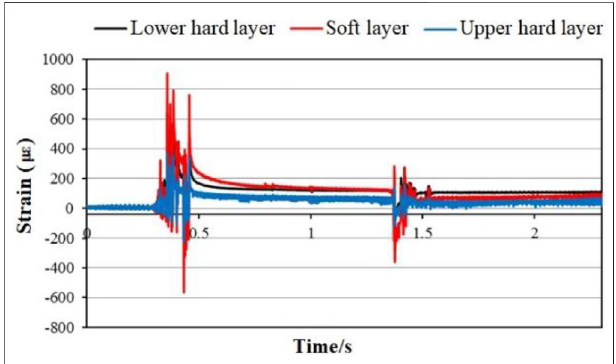
FIGURE 5 | Time-history curve of the vertical strain of each layer during simultaneous blasting of Nos 1, 2, and 3.